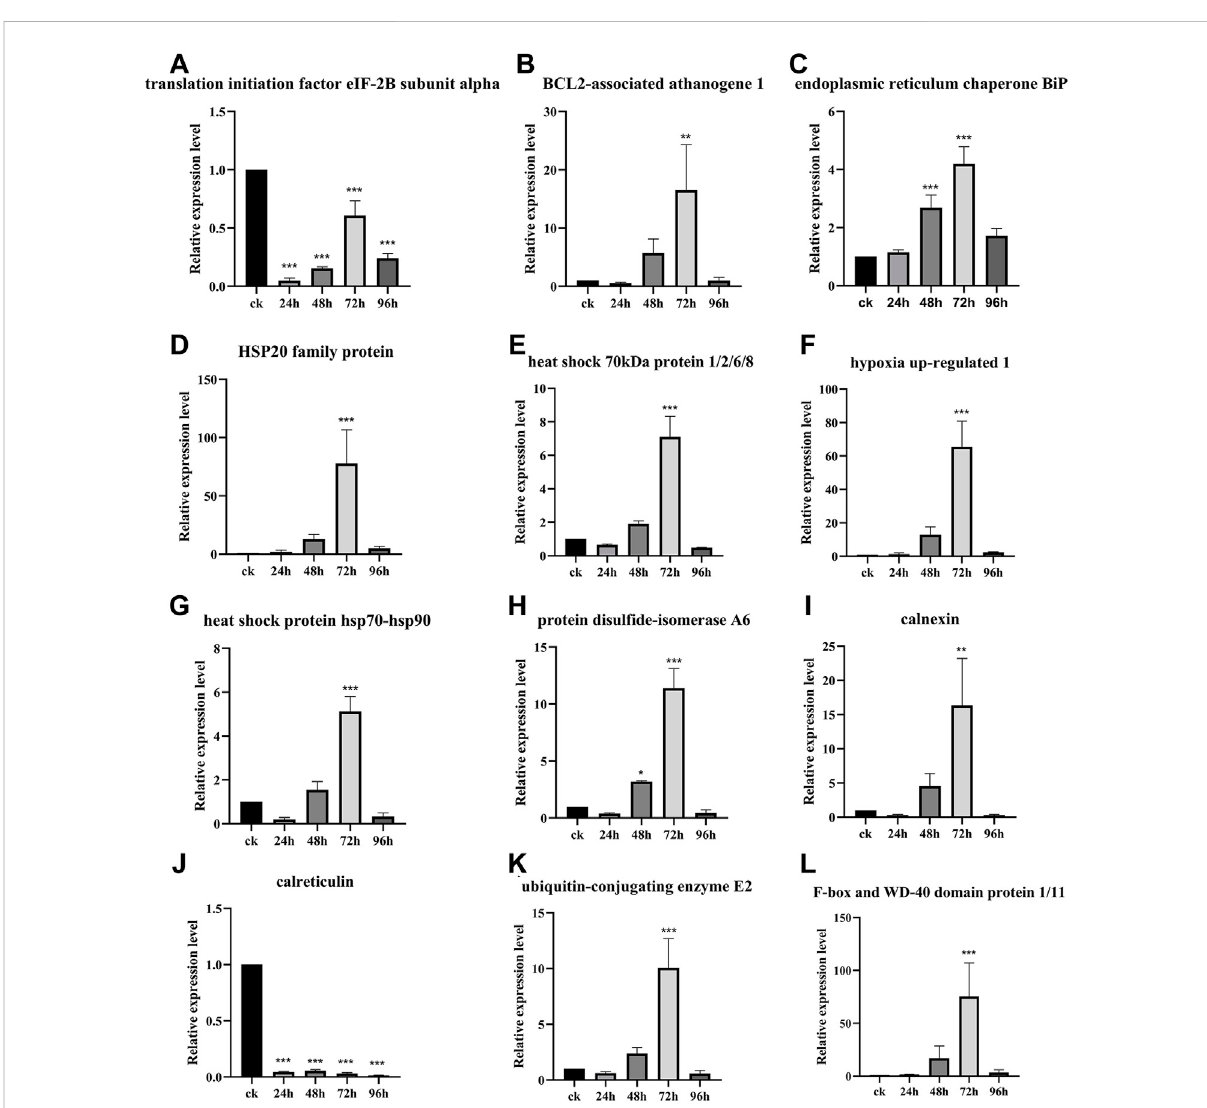
Gene relative expression analysis of the ER pathway-related genes. Data are shown as the mean of three biological replicates ± SD. The * representssigni fi cantdifference(** p < 0.01,*** p < 0.001,Student ’ s t -test). (A) TranslationinitiationfactoreIF-2Bsubunitalpha. (B) BCL2-associated athanogene1. (C) EndoplasmicreticulumchaperoneBiP. (D) HSP20familyprotein. (E) Heatshock70 kDaprotein1/2/6/8. (F) Hypoxiaupregulated1. (G) Heatshockproteinhsp70-hsp-90. (H) Proteindisul fi de-isomeraseA6. (I) Calnexin. (J) Calreticulin. (K) Ubiquitin-conjugatingenzymeE2. (L) F-box and WD-40 domain protein